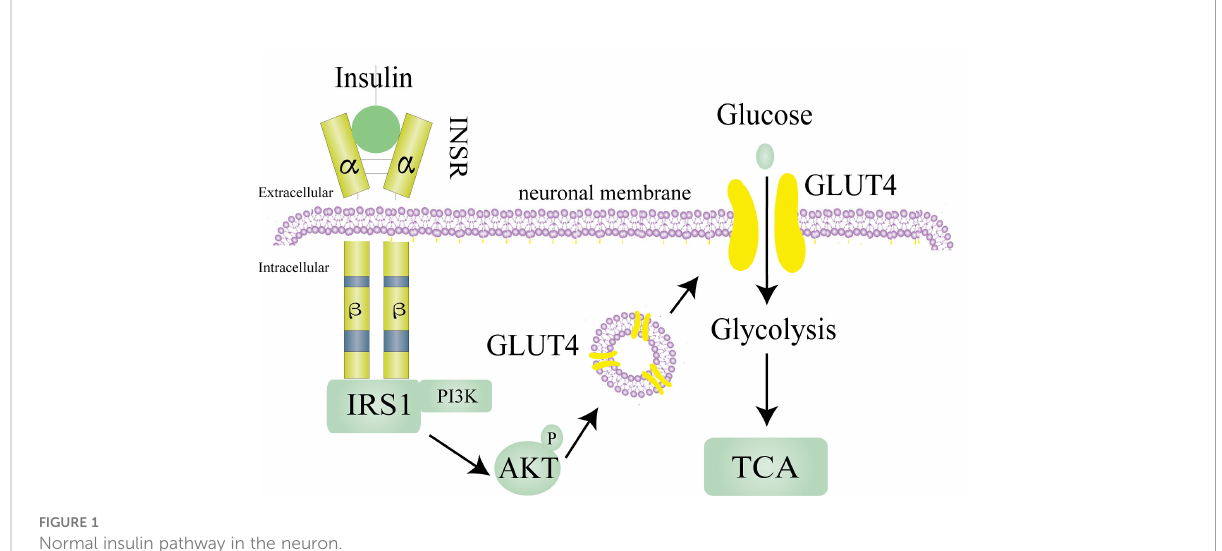
FIGURE 1 Normal insulin pathway in the